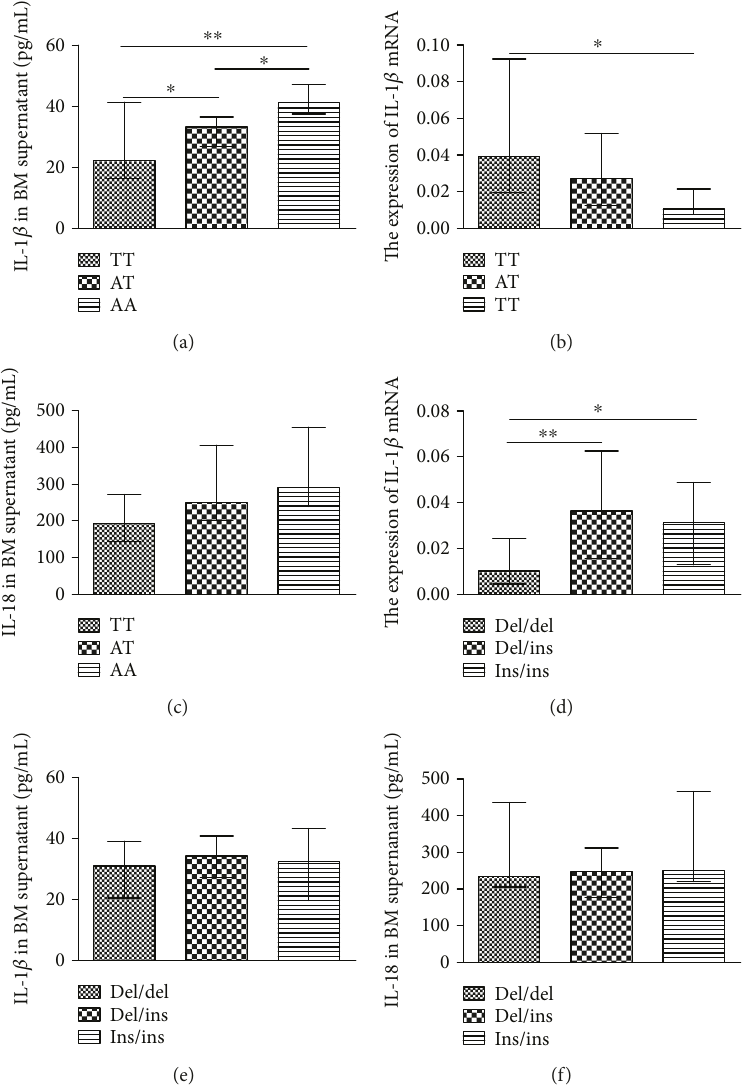
Figure 3: The genotypes of gene polymorphisms may a ff ect the downstream gene expression, mRNA, or protein in MM patients. (a) The relationship between the expression of IL-1 β in the BM supernatant and rs2043211 of CARD8. (b) The relative mRNA expression in the three genotypes of rs2043211 of CARD8. (c) The association between the expression of IL-18 in the BM supernatant and rs2043211 of CARD8. (d) The mRNA expression of IL-1 β in the genotypes for the NF- κ B polymorphism. (e-f) The expression of IL-1 β (e) and IL-18 (f) in the BM supernatant in the genotypes for the NF- κ B polymorphism. ∗ P < 0 05 and ∗∗ P < 0 01